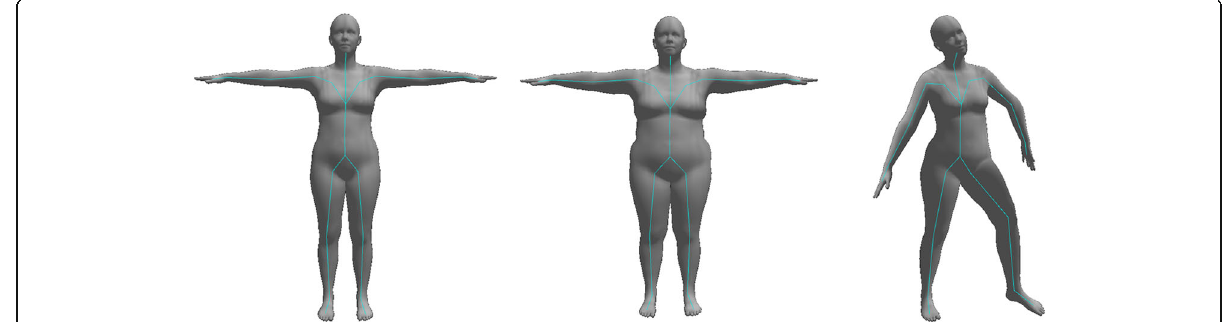
Fig. 5 Skinned Multi-Person Linear Model (SMPL) [79] body model. This model does not have an explicit skeleton. Instead, the surface of a person is represented by a mesh of triangles. A set of parameters (learnt through regression) allows the shape of the model to be changed from a neutral mean (left) to a fatter (middle) or thinner, taller, or other body shape. Once shaped, the centres of joints are inferred from the neutrally posed mesh, and then the mesh can be rotated around these joints to produce a posed body